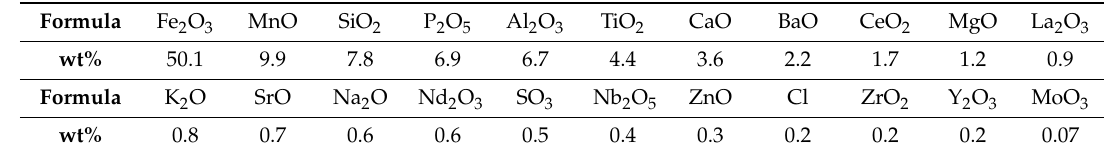
Figure 3. EDX spectra of REE-containing grains: ( a ) Ce oxide grain; ( b ) Nb oxide grain, which is host to minor Ce; ( c ) mixed REE oxide grain with Ca and P. Table 2. Chemical composition of the REE ore.